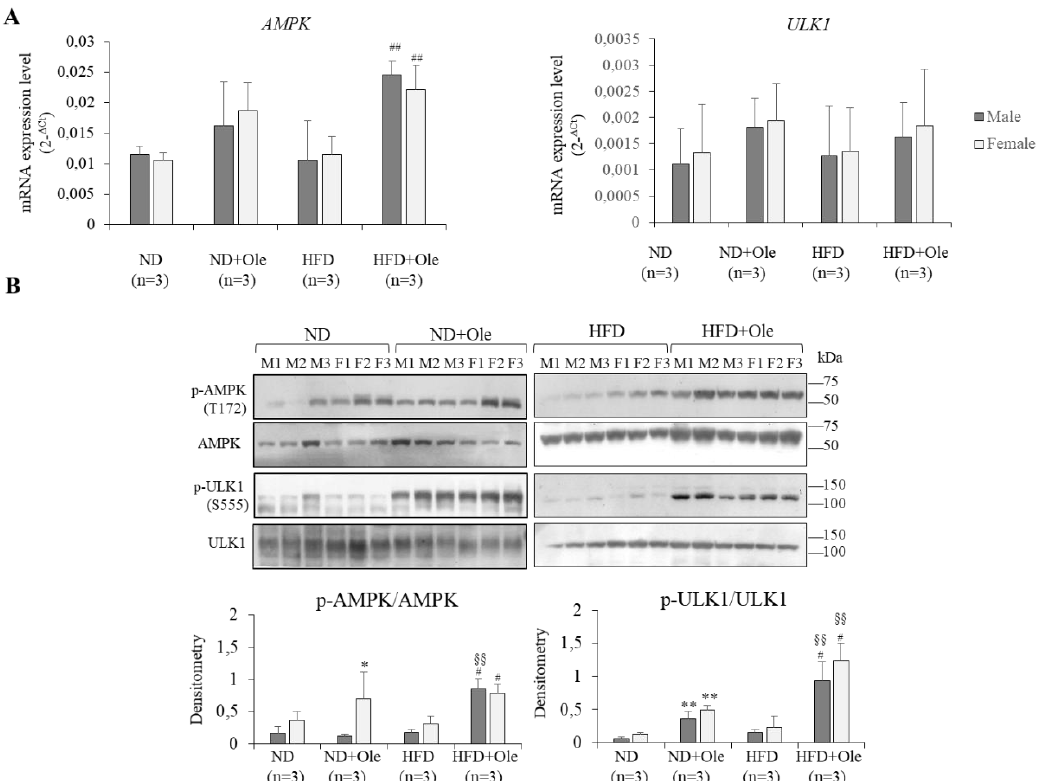
Figure 3. Activation of AMPK/ULK1 pathway by Ole in ND and HFD mice ( A ) AMPK and ULK1 expression, evaluated by Q-PCR, in ND and HFD in male (M) and female (F) mice in presence or not of Ole. Gene expression values are expressed as 2 − ∆ C t values. The results are reported as mean ± SD. ( B ) Western blot analysis and relative densitometry of pAMPK/AMPK and pULK1/ULK1 protein expression in ND and HFD in M and F mice in presence or not of Ole. Values are expressed as fold mean ± SD. * p < 0.05, ** p < 0.01 vs. ND; # p < 0.05, ## p < 0.01 vs. HFD; §§ p < 0.01 vs. ND + Ole.